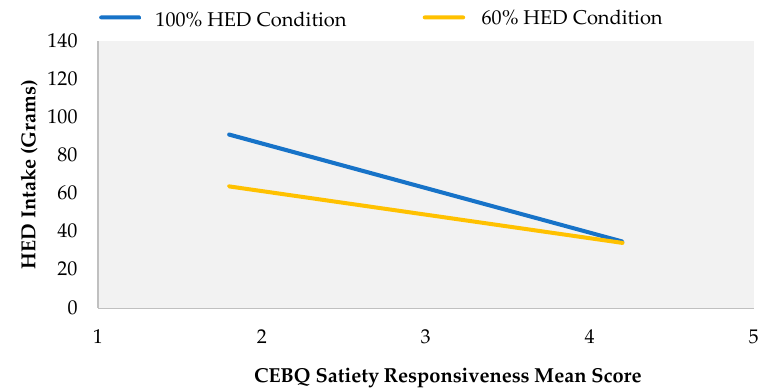
Table 4. 100% HED intake regression model. B